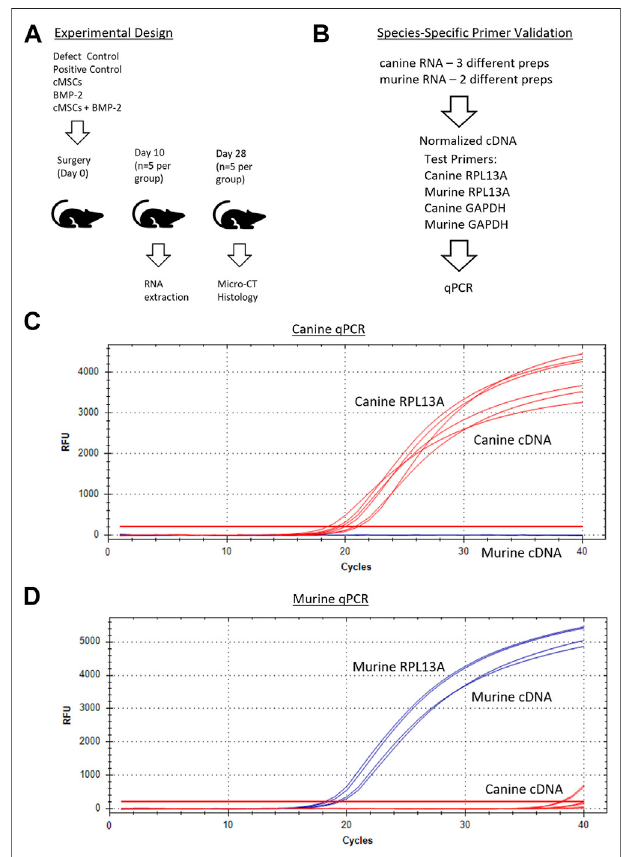
FIGURE 2 | Overall experimental design and species-speci fi c primer development and validation. (A) : Surgical treatment groups included a negative control (defect control), positive control (100 μ g/ml BMP-2), 2 × 10 6 cMSCs, sub-therapeutic BMP-2 (6 μ g/ml), or cMSCs + BMP-2 (6 μ g/ ml). Mice were terminated for RNA extraction (Day 10) or μ CT and histology (Day 28). (B) : qPCR primer design and validation schematic for canine and murine RNA samples. Primer pairs that ampli fi ed RPL13A and GAPDH in a species-dependent manner were selected for further use. (C, D) : Canine and murine RPL13a qPCR ampli fi cation curves for canine cDNA (red lines) and murine cDNA (blue lines). Canine and murine RPL13a primer-pairs resulted in species-speci fi c ampli fi cation and were used in subsequent